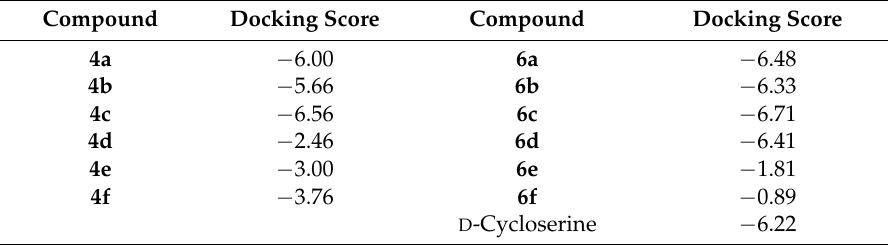
Table 8. Docking score of the synthesized compounds 4 ( a – f ) and 6 ( a – f ) for DdlB enzyme. Compound Docking Score Compound Docking